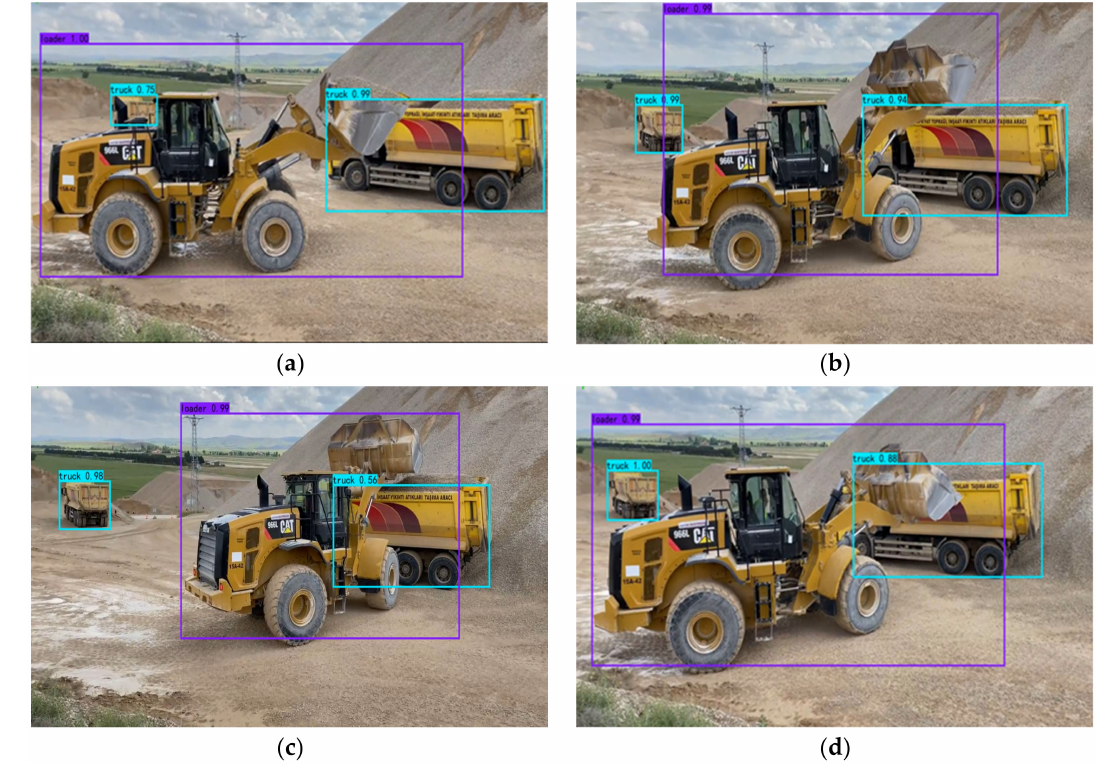
Figure 9. Example improved model detection results for video 1 under occlusions. ( a ) Frame 2229, ( b ) Frame 2278, ( c ) Frame 2331, ( d ) Frame 2930.